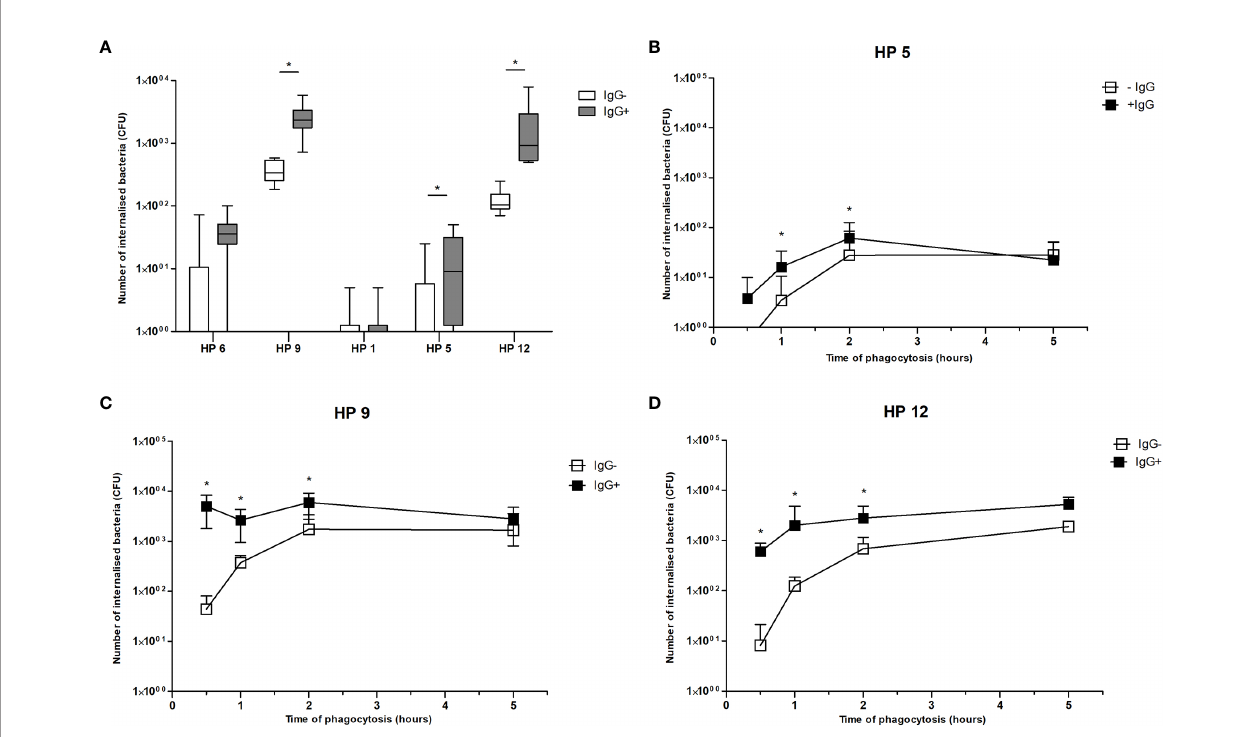
FIGURE 5 | Phagocytosis assay. Data show presence of G. parasuis strains pre-incubated with (IgG+) or without (IgG-) the post-vaccinal IgG in lysed PAMs after one hour of phagocytosis (A) or after 0.5, 1, 2 and 5 h of phagocytosis (B – D) . Signi fi cant difference between groups with or without the post-vaccinal IgG is denoted by asterisk (p<0.05).